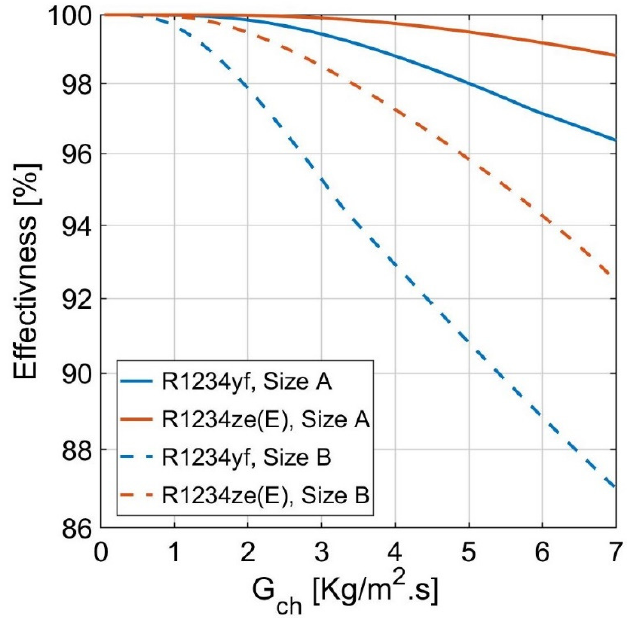
Figure 16. Effectiveness at different plate sizes: size A (marked with solid lines) and size B (marked with dashed lines) at various cold channel mass fluxes.